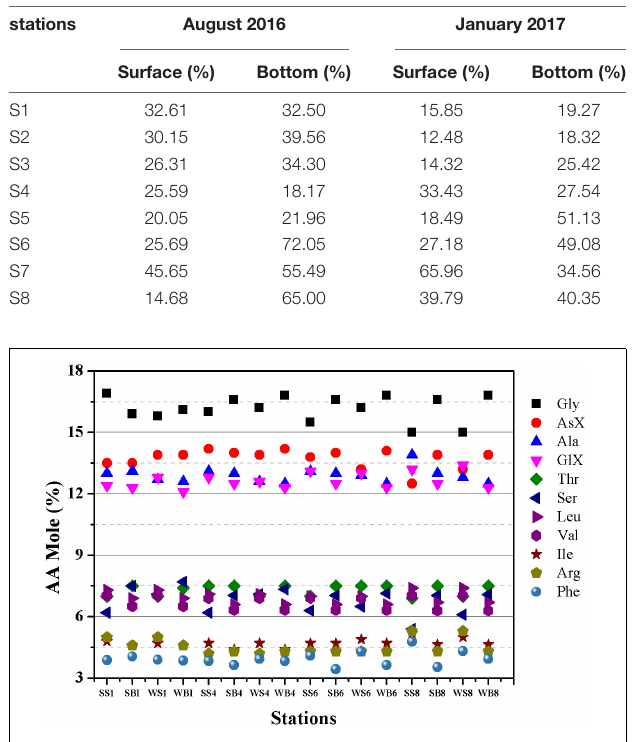
FIGURE 7 | Amino acid spectra (mole percentages ≥ 3%) in particulate matter in the Pearl River estuary (SS1-SS8 and SB1-SB8 were the surface and bottom samples during summer at stations of S1, S4, S6, and S8, respectively; WS1-WS8 and WB1-WB8 were the surface and bottom samples during winter at stations of S1, S4, S6, and S8,